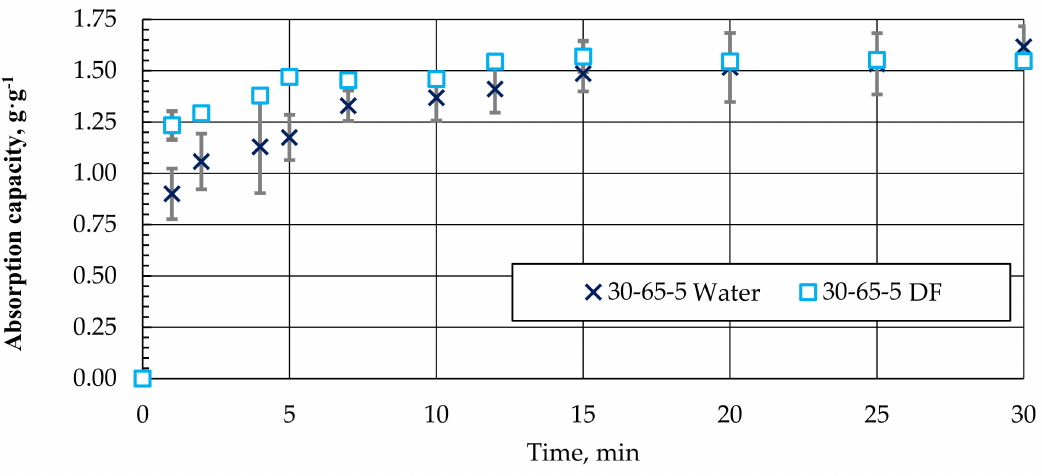
Figure 14. Absorption kinetics (approximation) of water and DF for granules with a composition of